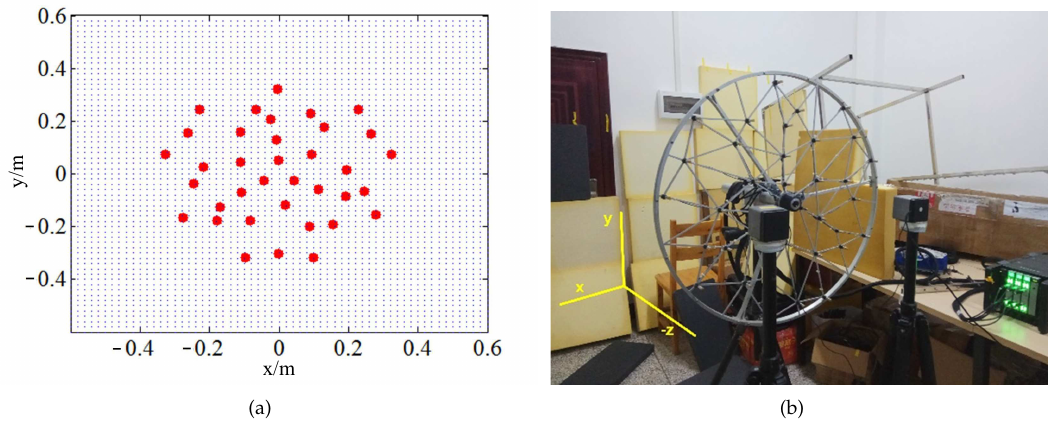
Figure 7. The test arrangement of experiments: ( a ) microphones array and focal points; ( b ) test site of coherent